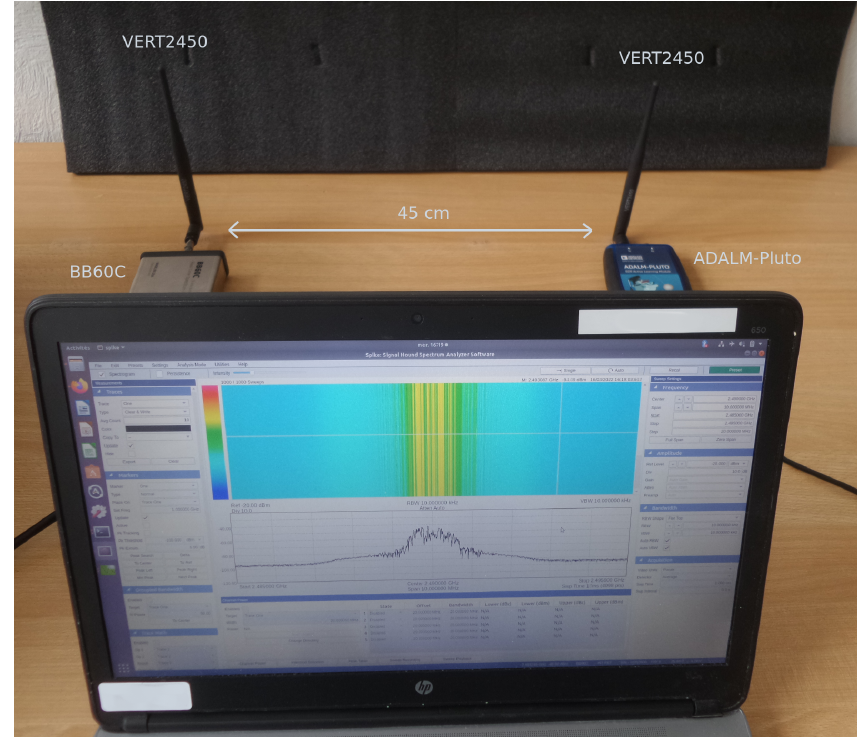
Figure 7. Testbed of the